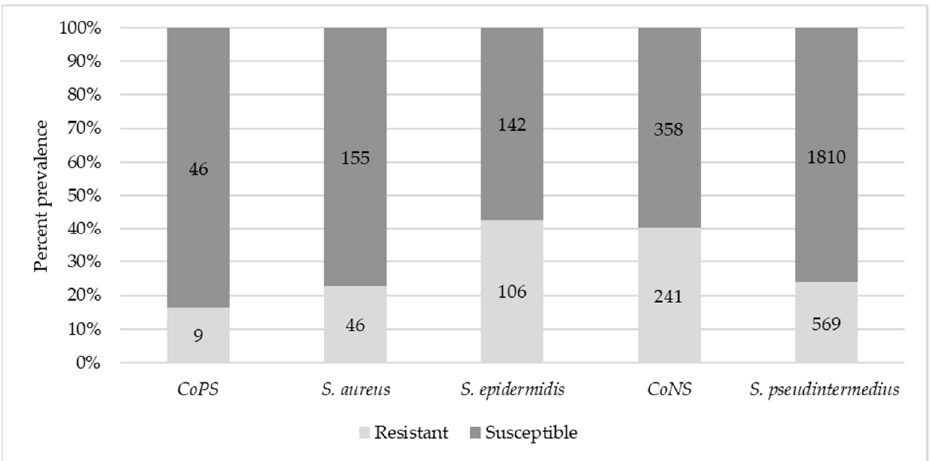
Figure 1. Prevalence of methicillin-resistant Staphylococcus spp. from companion animal clinical cases tested in this study. Total number of resistant and susceptible isolates are shown in the horizontal bars for each organism category. CoNS, coagulase-negative staphylococci excluding S. epidermidis ; CoPS, coagulase-positive staphylococci excluding S. aureus and S. pseudintermedius .